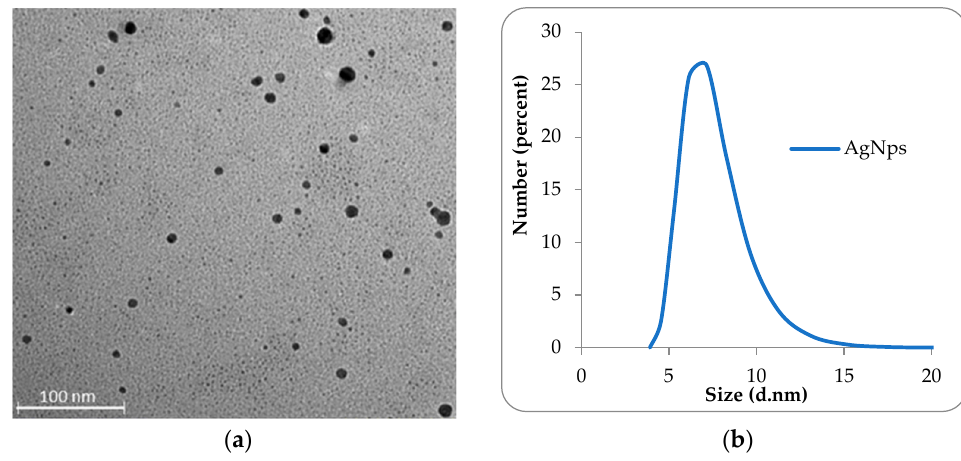
Figure 2. TEM image ( a ) and size distribution curve in number for AgNps ( b ) .